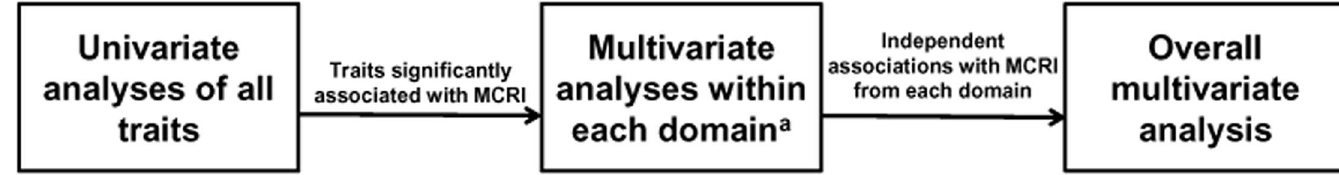
Fig 1. Three stages of statistical analyses. All analyseswere donewith MCRI as the dependentvariable.Traits that were significantin univariate analysiswere includedin the multivariate analyseswithin each domain.The overall multivariate analysisincludedtraits that were significantfrom each of the within-domain analyses. a Domains includeanthropometry, biomarkers, cardiovascular, glucosehomeostasis, lipaseactivity, lipid profile, and liver function